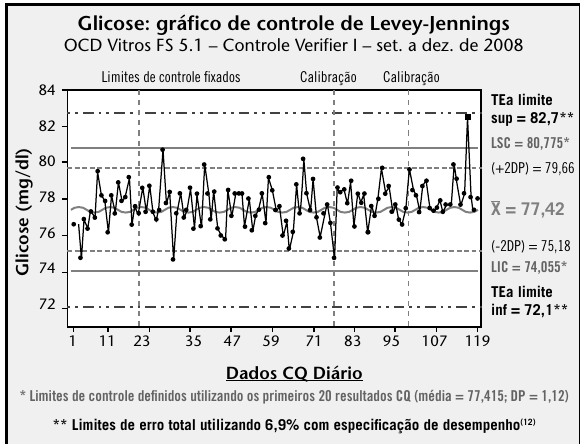
Figura 2 – Análise de imprecisão de longo prazo: gráfico de controle de Levey-Jennings, glicose Vitros FS 5.1, setembro a dezembro de 2008 ( n = 119) TEa: limites de erro total; LSC: limite superior de controle; DP: des- vio padrão; LIC: limite inferior de controle; CQ: controle da qualidade.